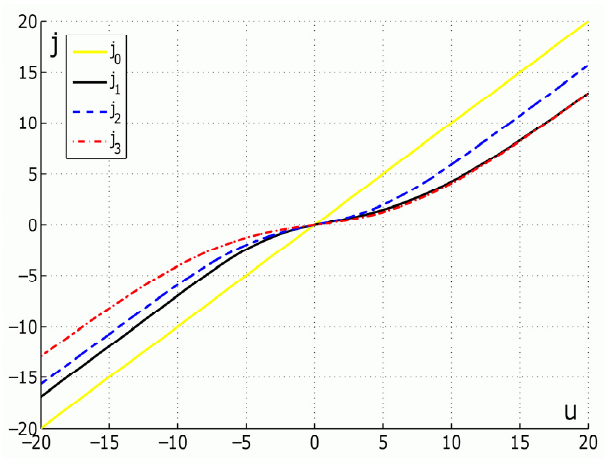
Fig. 2: A linear current density versus voltage plot of the three energy profiles (asymmetric triangular profile, j 1 , symmetric triangular profile, j 2 , trapezoidal profile, j 3 ) and bulk current density ( j 0 ) for an energy barrier height of w = 2.15 (in kT units), a relative size of the entrance region of the pore of r = 0.3, and voltage, u , in kT/q units. The linear behavior at high voltages is clearly visible for the chosen voltage